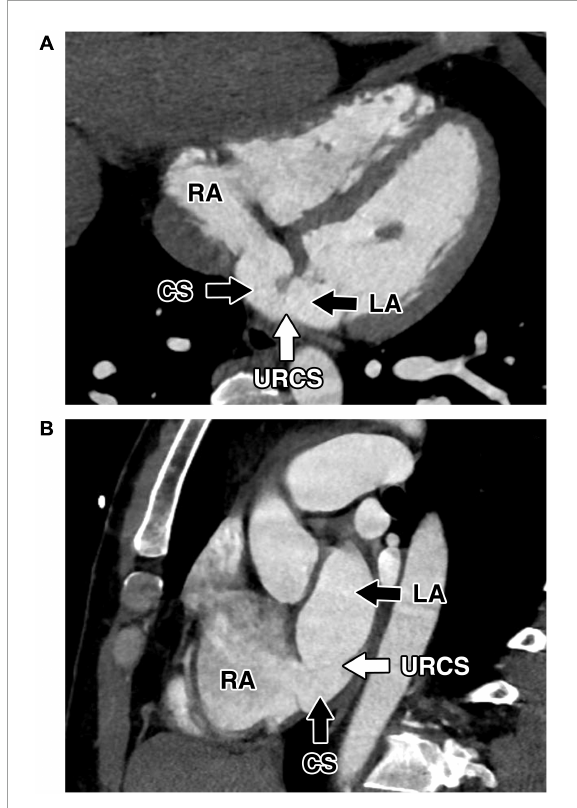
FIGURE3 Preoperative cardiac computed tomography. Computed tomography showed extensive communication between the coronary sinus and left atrium caused by partial absence of the roof of the coronary sinus. The absence of the coronary sinus roof and communication between CS and the left atrium. (A) Modified four-chamber projection. (B) Modified short-axis projection. CS, coronary sinus; LA, left atrium; RA, right atrium; URCS, unroofed coronary sinus.